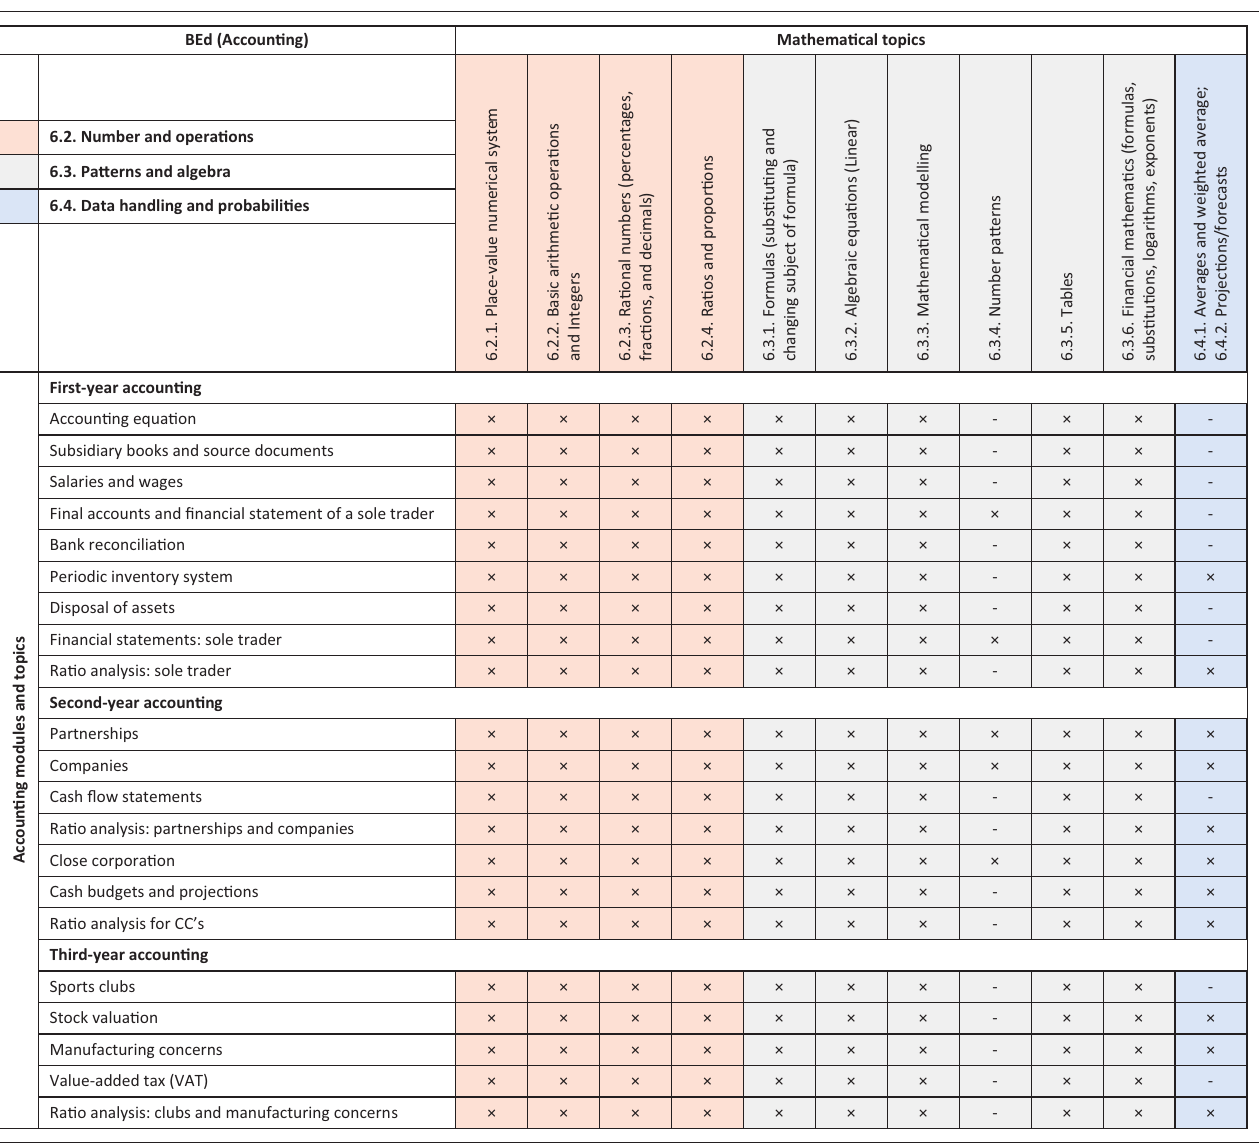
FIGURE 29: Bachelor of Education Accounting curriculum: Elements of mathematics knowledge and